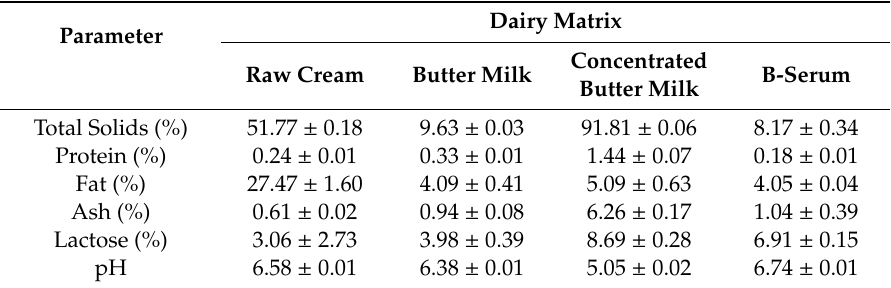
Table 1. Composition of dairy byproducts used for the extraction of phospholipids.